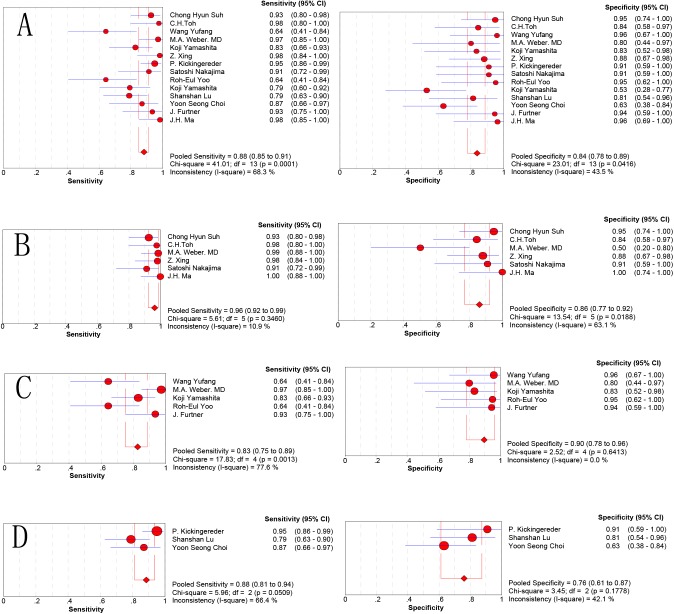
Forest plot showing the sensitivity and specificity of different groups for the differentiation of HGGs from PCNSLs.(A) Overall group; (B) DSC group; (C) ASL group; (D) DCE group.